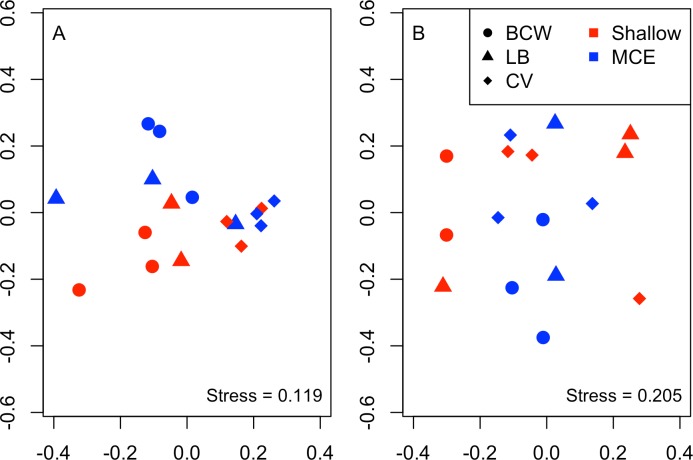
Nonmetric multidimensional scaling plot for (A) abundance and (B) biomass of the invertebrate and fish larvae.Colours indicate different depths, while shapes indicate different survey sites. Sites were: BCW, Black Coral Wall; LB, Little Bight and CV, Coral View.